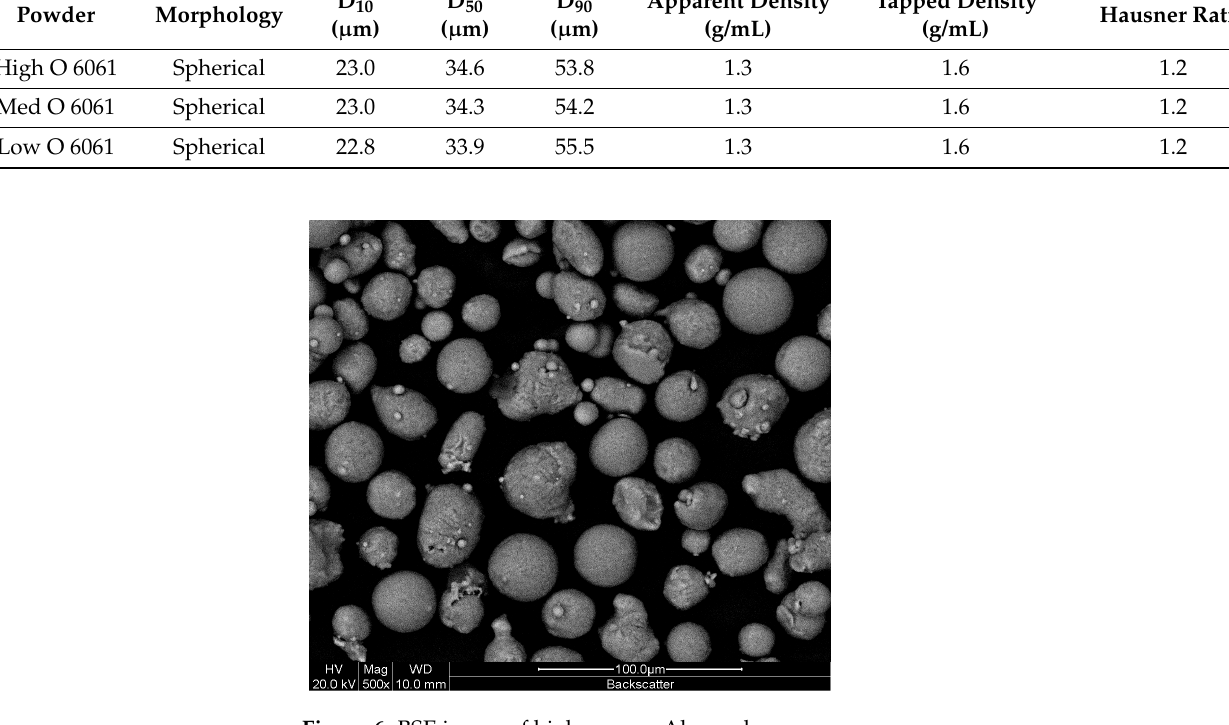
Figure 6. BSE image of high oxygen Al powder.